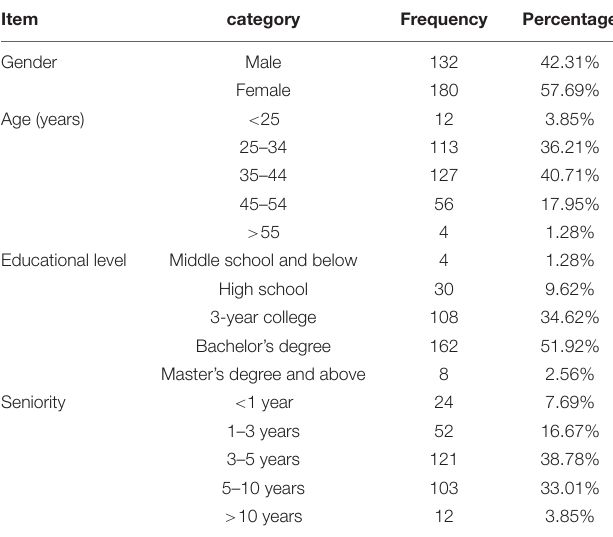
TABLE 1 | Demographic characteristics of respondents ( N =